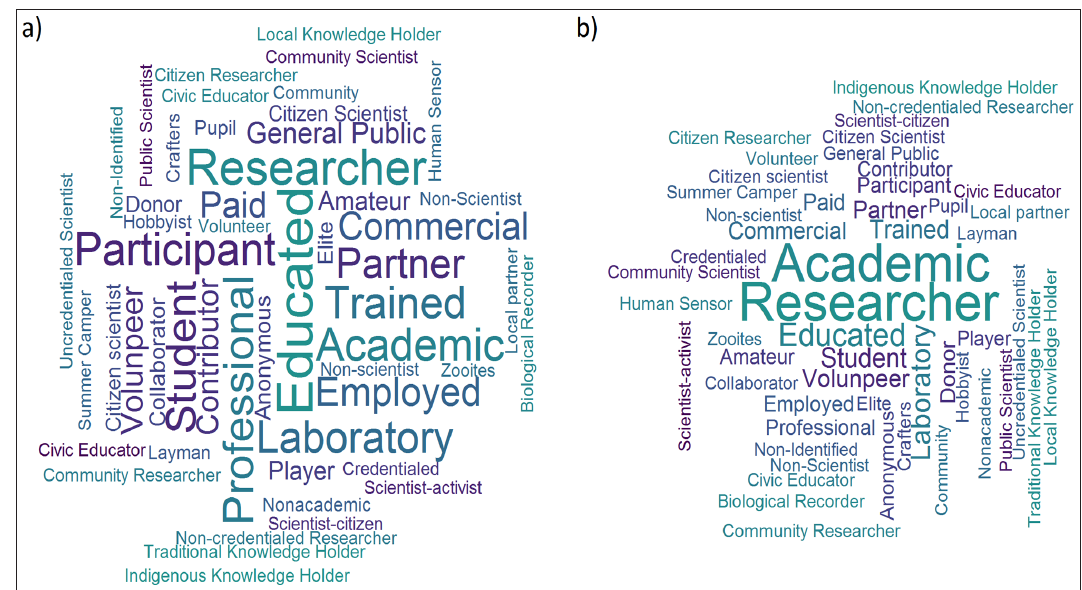
Figure 2: Word clouds for various citizen science participant terms in a) Google Scholar and b) Google News searches from December 2016. Terms corresponding to ‘citizens’ are colored in shades of purple, and terms corresponding to ‘scientists’ are colored in shades of blue-green (note that ‘citizen scientist’ appears twice, once for ‘citizens’ and once for ‘scientists’). Words with higher frequency are larger. All terms were searched along with the phrase ‘citizen science,’ and Appendix A provides the frequencies for each search term along with the exact search